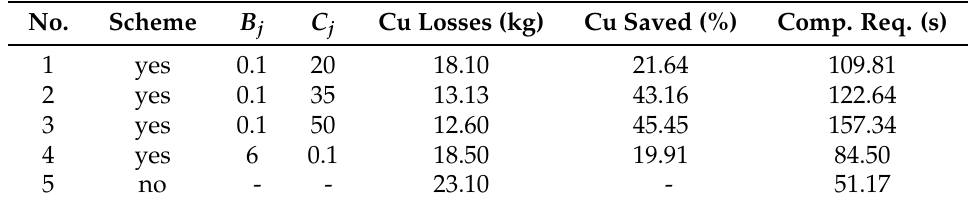
Table 2. Framework performance for different